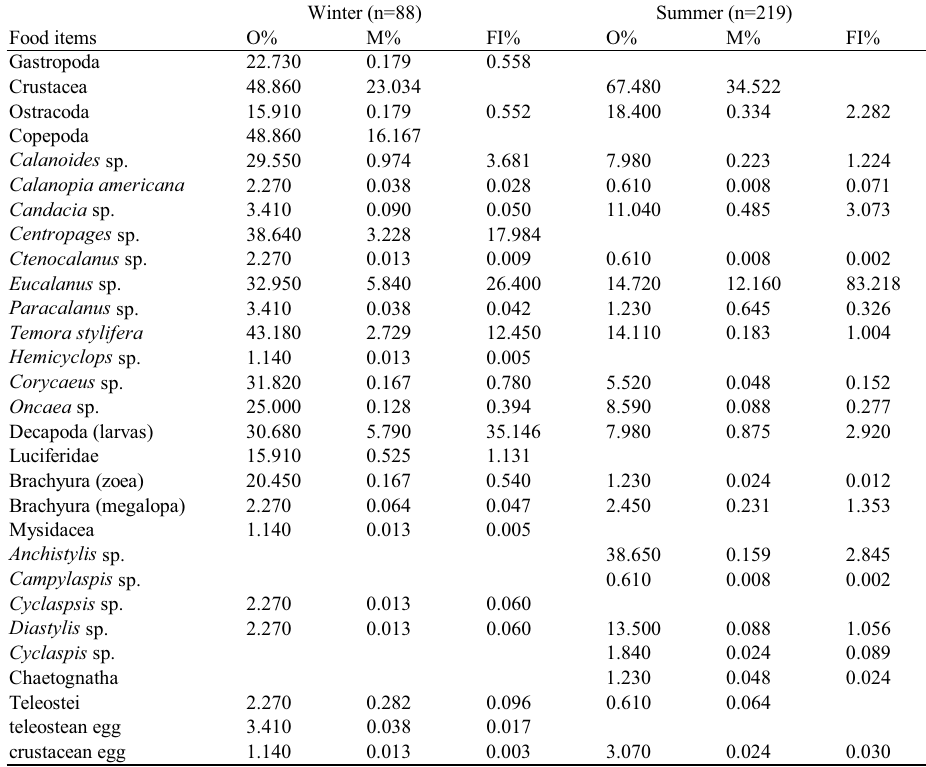
Table 2. Frequency of occurency (O%), percent mass (M%), and feeding index (FI%) of food items of Trachurus lathami collected in winter and summer from Brazilian shelf off Ubatuba.